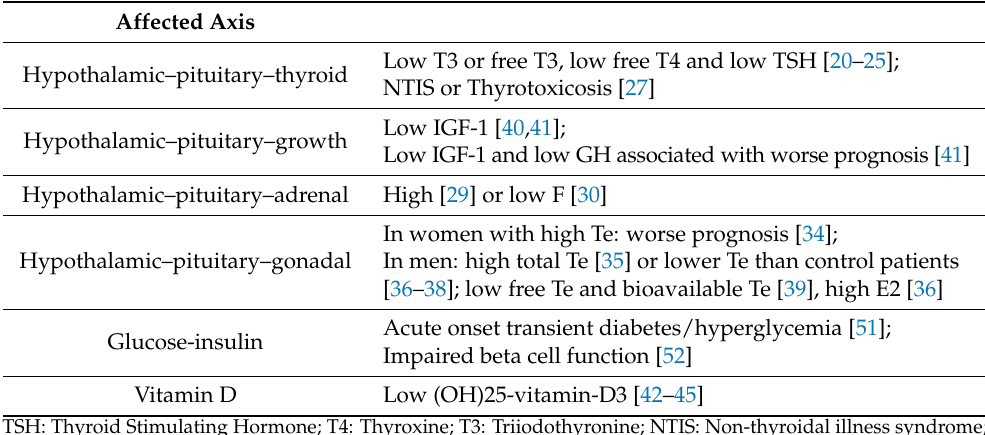
Table 2. Summary of endocrine aspects of ICU-hospitalized patients with COVID-19. Affected